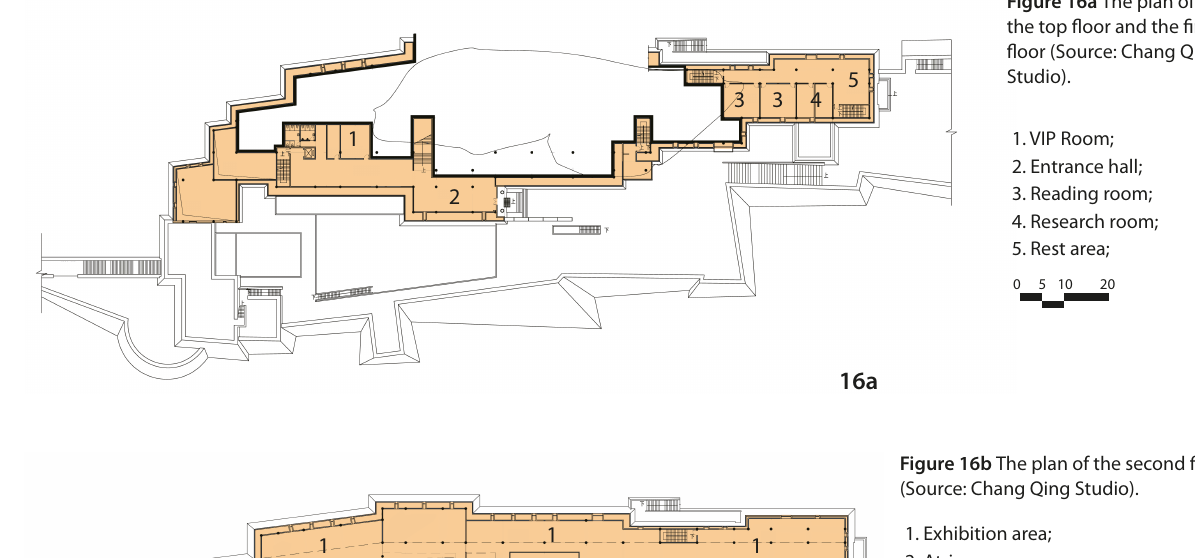
Figure 16a The plan of the top floor and the first floor (Source: Chang Qing